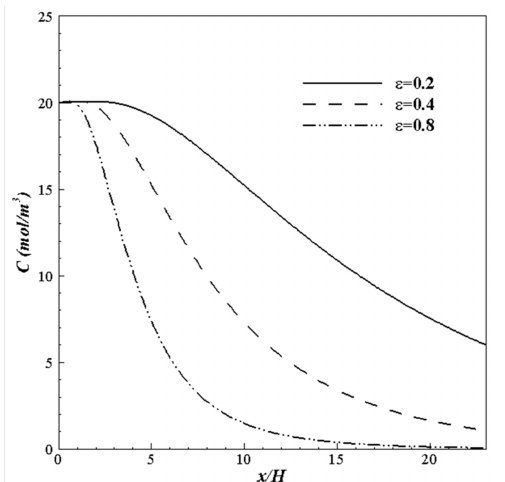
Figure 15. The variation in concentration versus the length to height ratio of the porous collector for the three different porosity coefficients of 0.2, 0.4, and 0.8 at t = 0.1